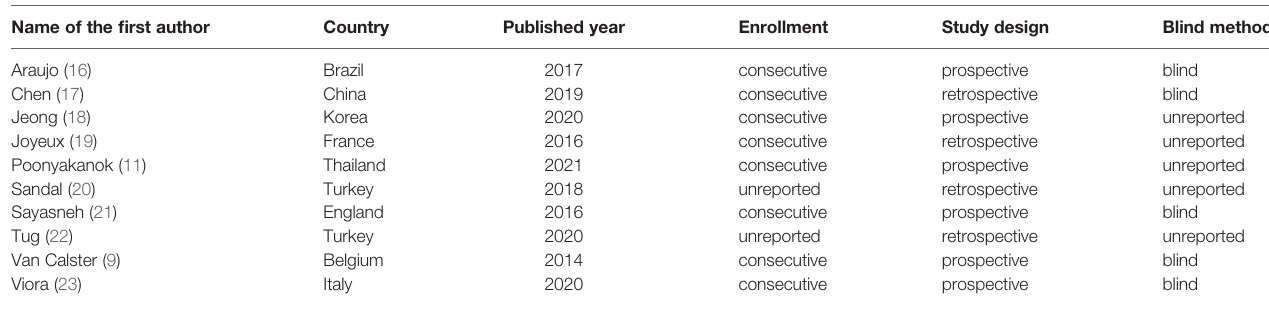
TABLE 1 | Basic features of the eligible